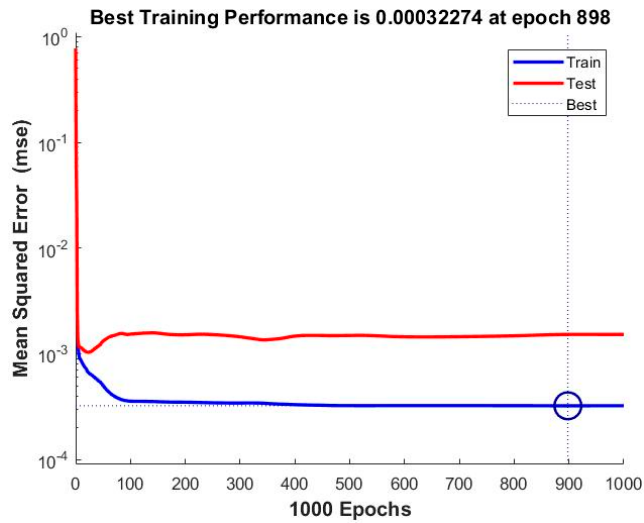
Figure 15. The best training performance when forecasting the electricity consumption for the month of December, using the ANN_NARX_BR_TS network.